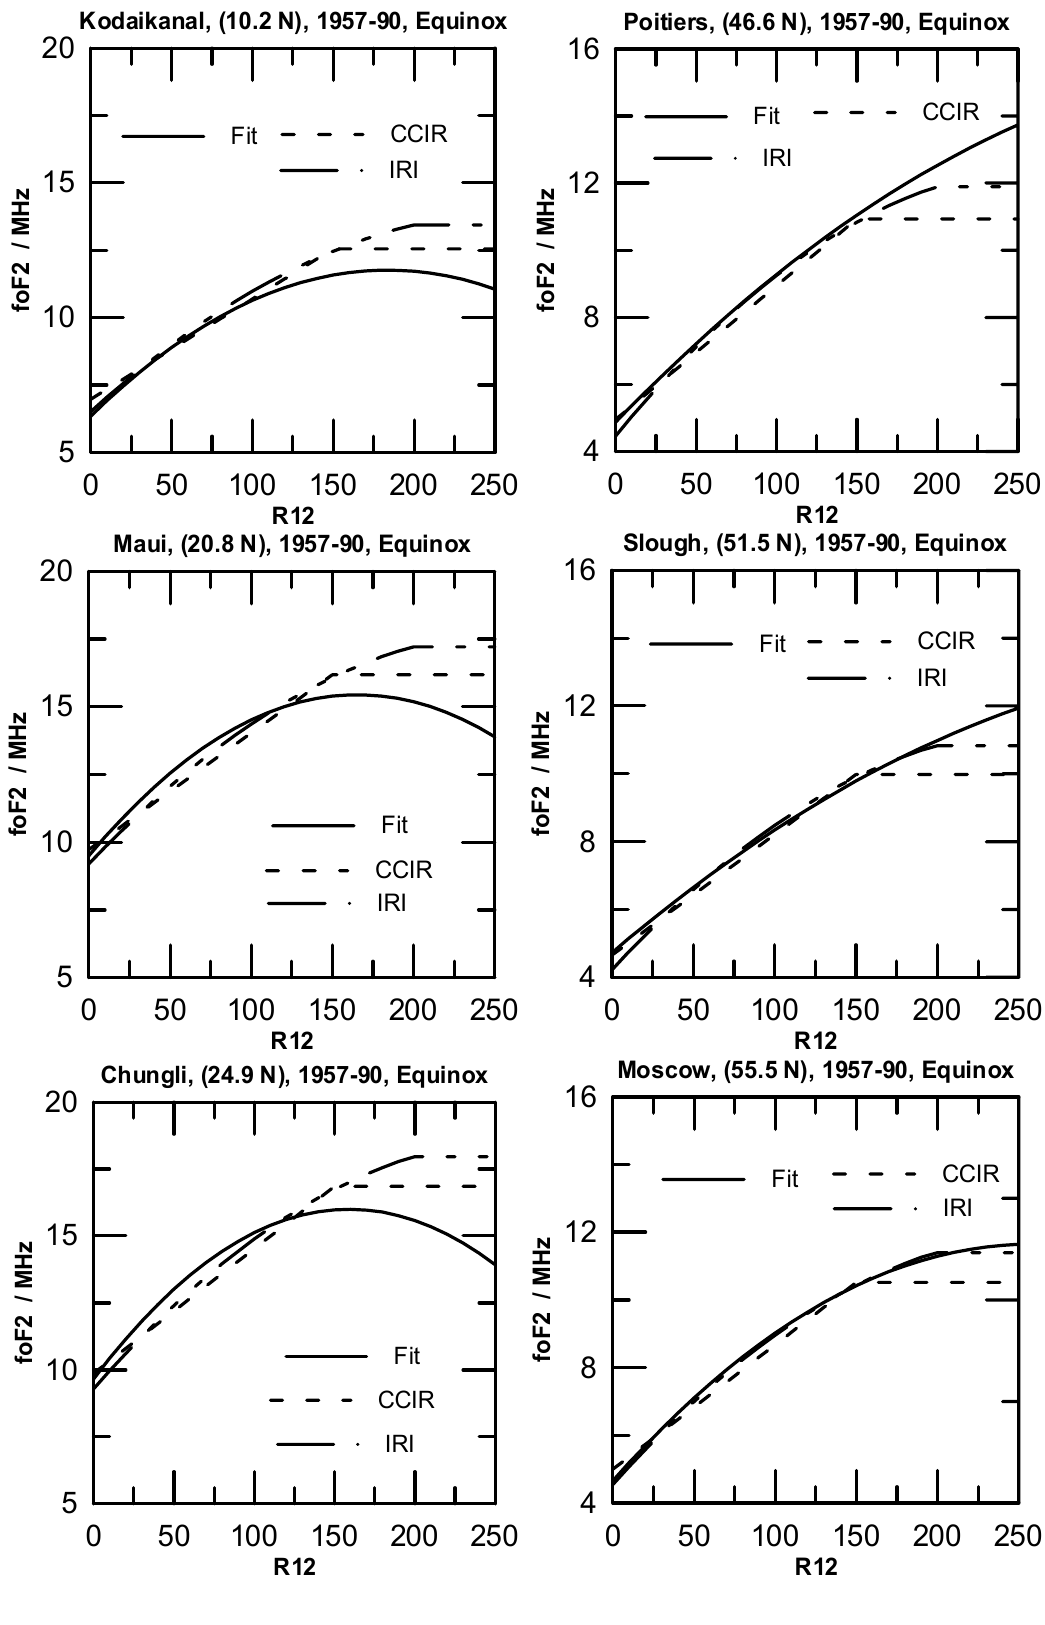
Fig. 6. Same as Fig. 4 but for